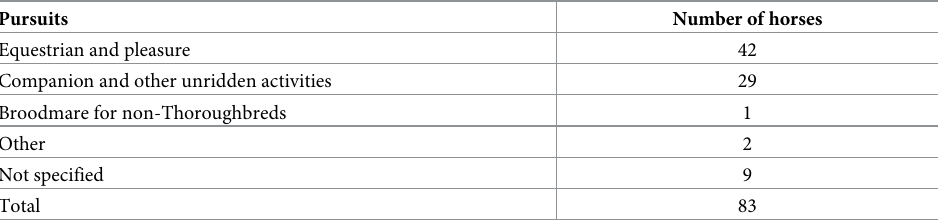
Table 5. Types of pursuits when retired or rehomed.